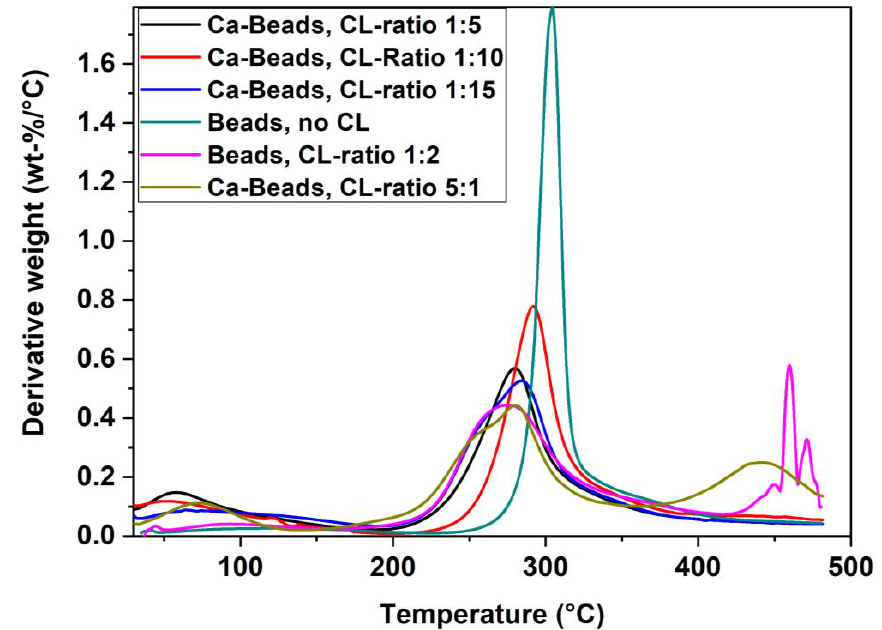
Figure 3. TGA profiles of the calcium doped beads with variable cross-linking (CL) ratios relative to the non-imbibed chitosan beads without cross-linking (no CL). The derivative weight scaling is truncated for the latter bead system.